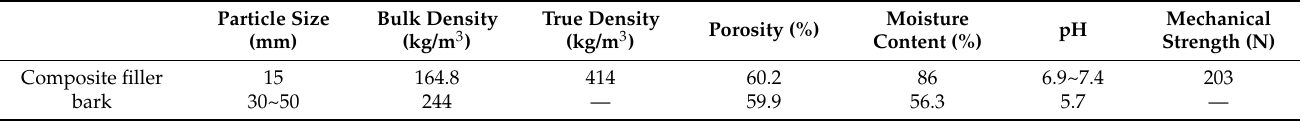
Table 3. Characteristics of filler.